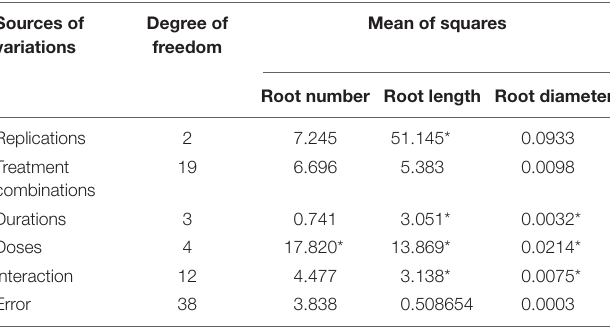
TABLE 2 | Factorial analysis of data for root parameters on varying doses and durations of NAA treatments in apical cuttings of CSIR-IHBT-VJ-05 ( Valeriana jatamansi ).